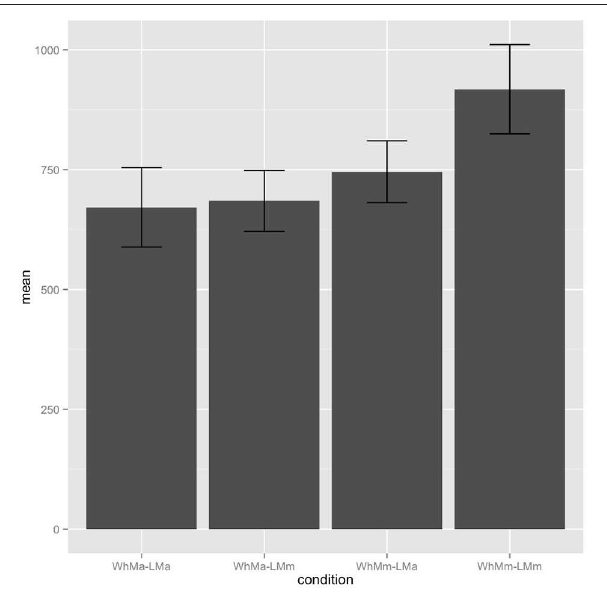
FIGURE 1 | Experiment 1 spillover region regression path